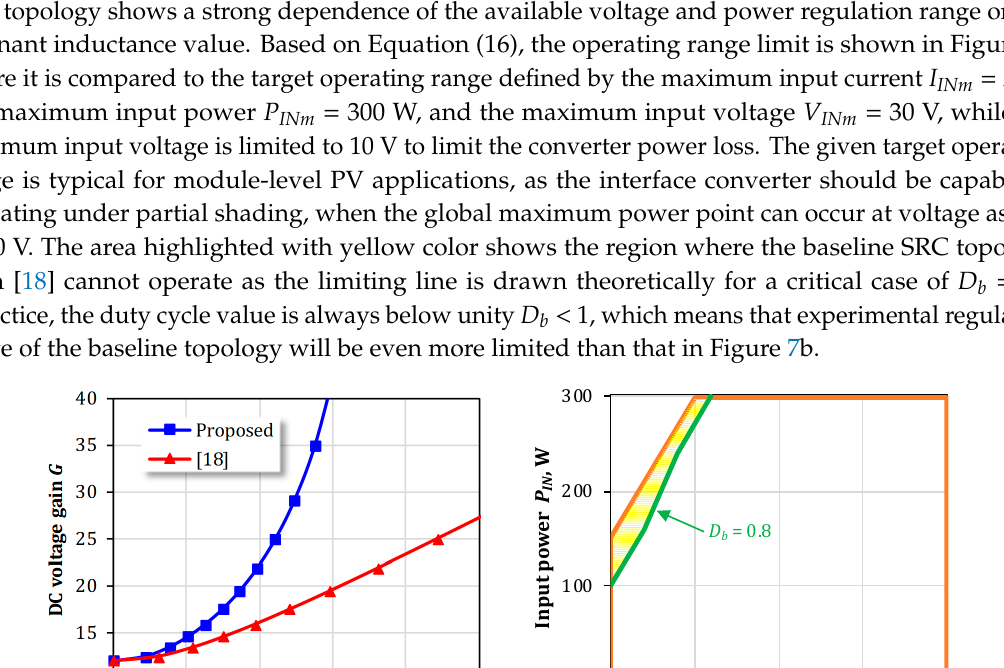
Figure 12. Comparison of the measured efficiency of the proposed and the baseline converters versus ( a ) the input voltage at two power levels and ( b ) the input power at different input voltage levels.